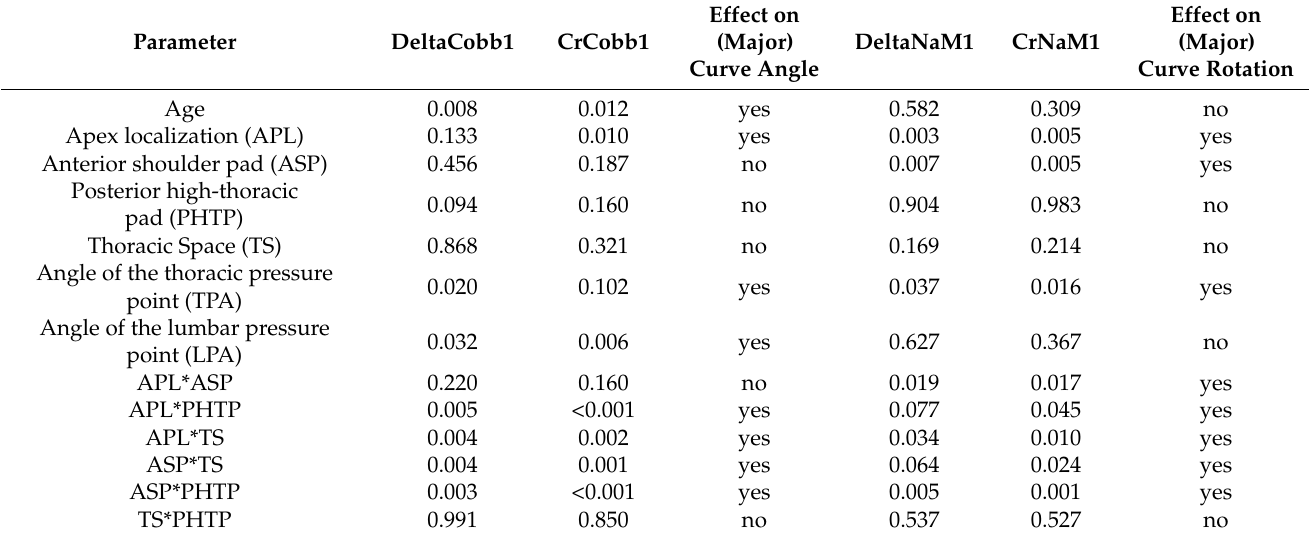
Table 3. Major curve analysis results ( p